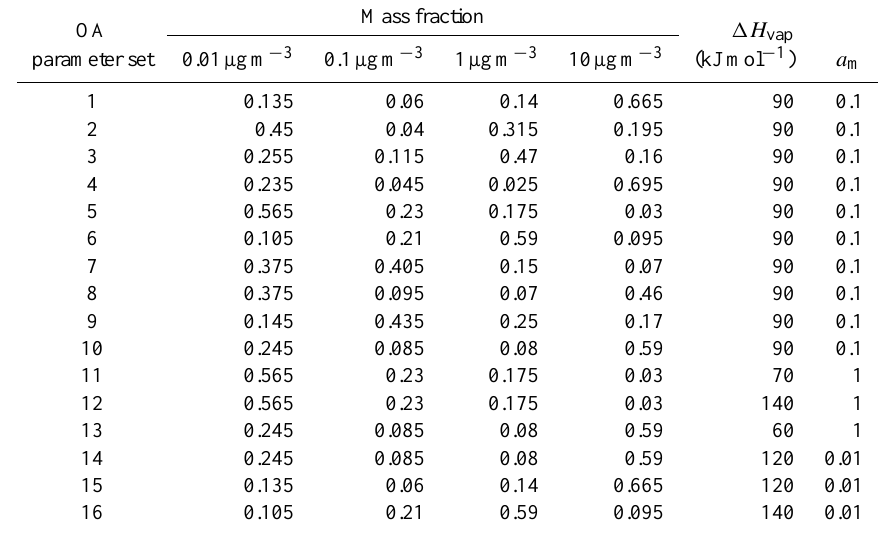
Table 2. Sets of random volatility distributions used for the evaluation of different inversion approaches.